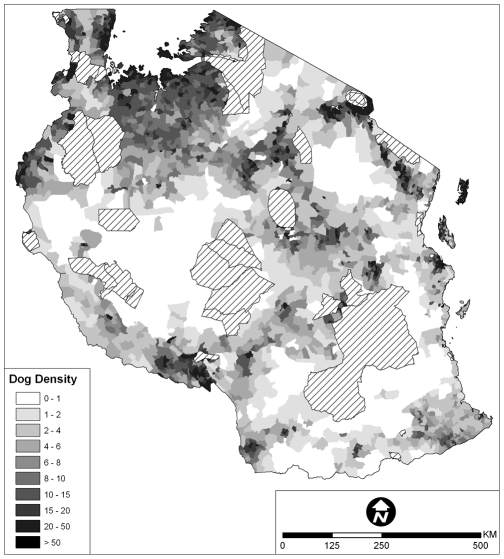
‘Dog density’ map of Tanzania (courtesy of Hawthorne Beyer; data source: LXV in Appendix S1).Hashed areas represent the location of wildlife protected areas.